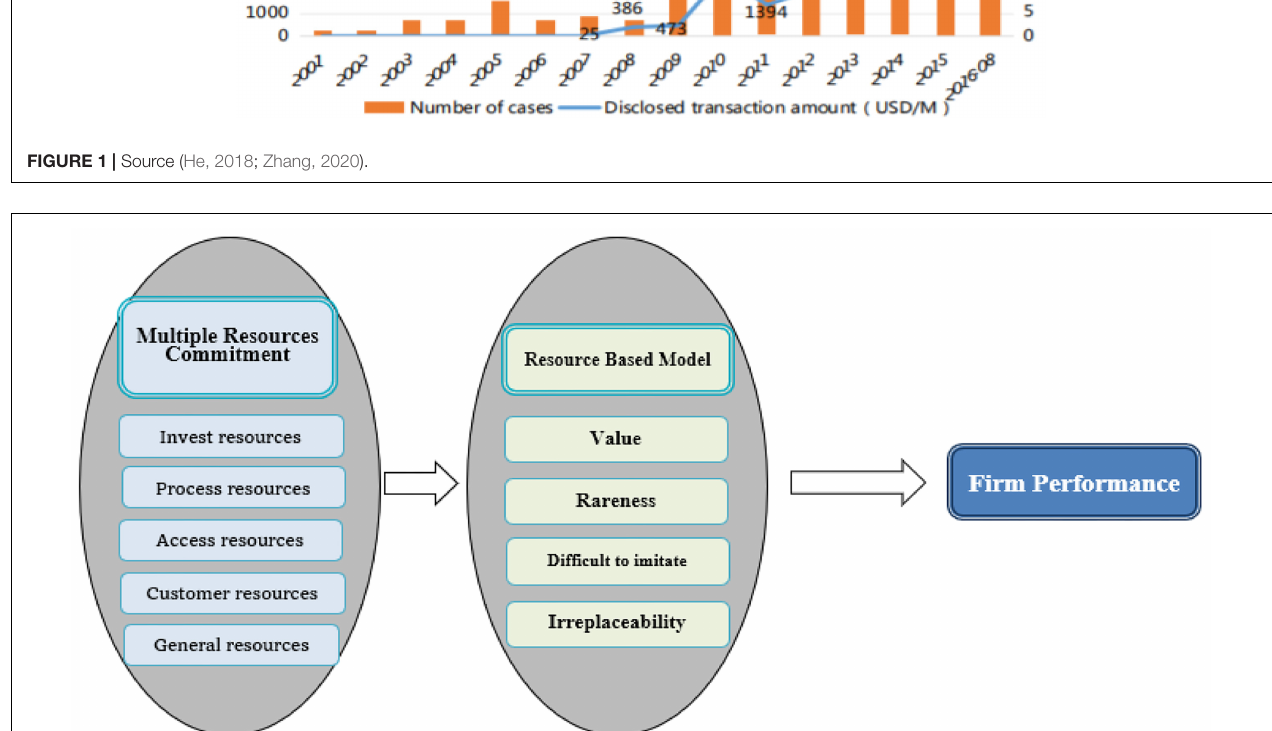
FIGURE 2 | Analysis framework based on resource-based